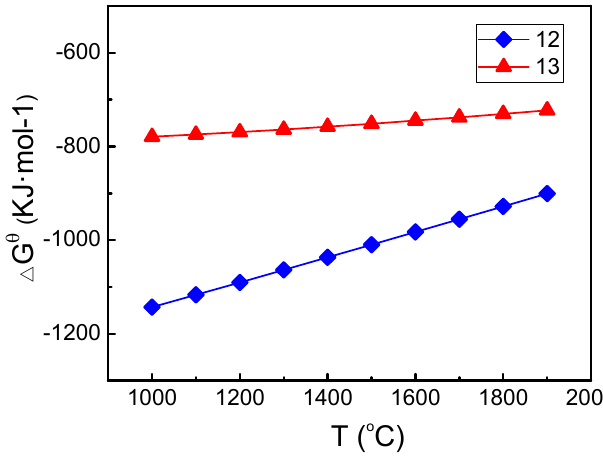
Figure 7. Relationships between Δ G θ (kJ ∙ mol − 1 ) and temperature (°C) in Reactions (12) and (13).